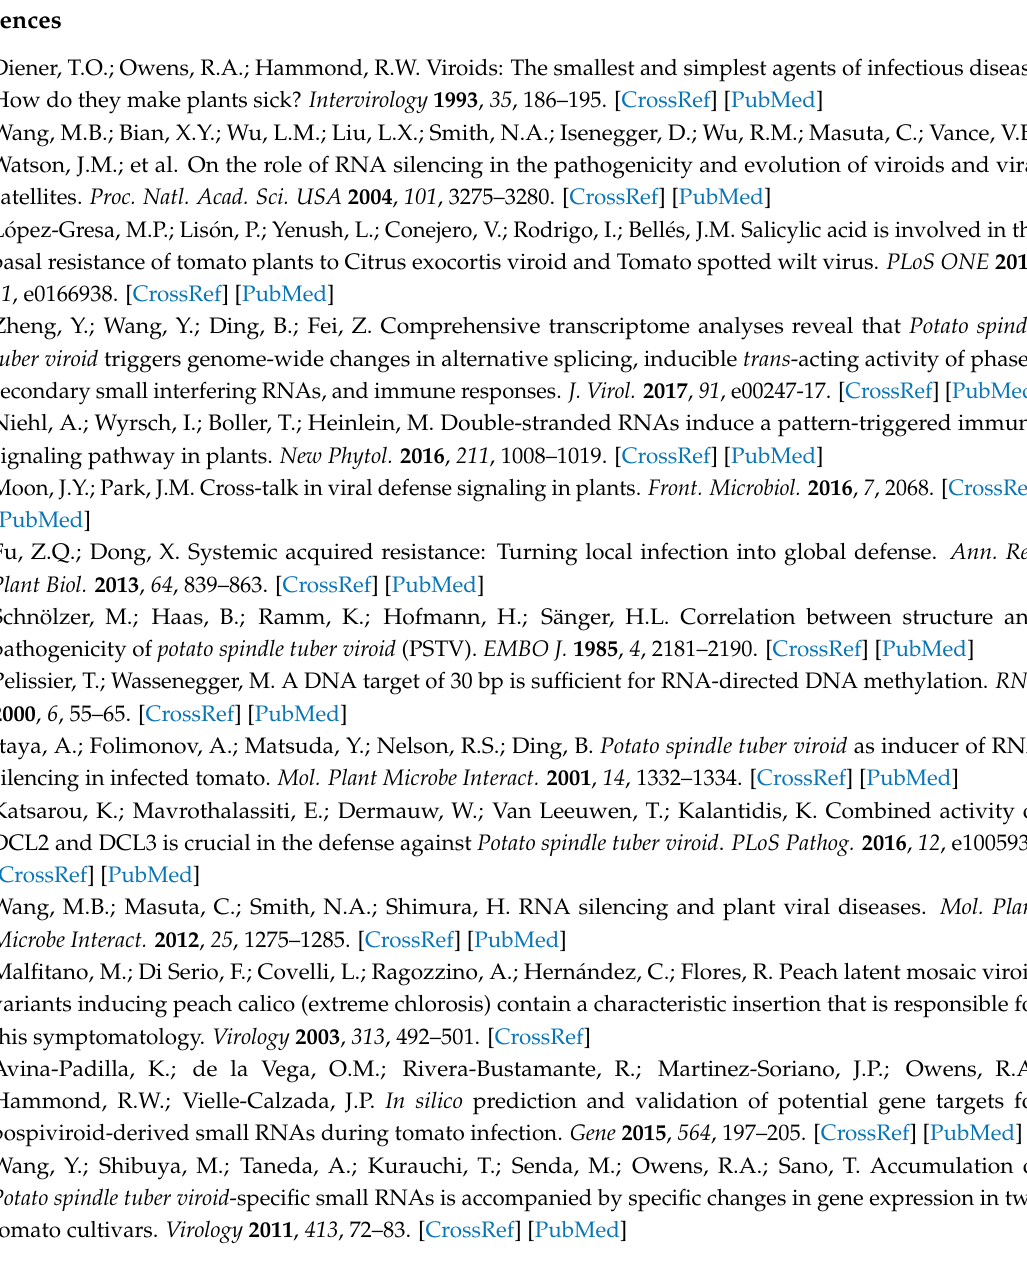
related genes, Table S18: Expression of RNA-dependent RNA polymerase related genes, Table S19: Disease related genes upregulated in infected plants for both PARE and small RNA reads, Table S20: Downregulated genes related to translation, Table S21: Differentially expressed pentatricopeptide genes, Table S22: Downregulated genes related to photosynthesis, Table S23: Differentially expressed genes related to membrane proteins, Table S24: Upregulated excreted protein genes, Table S25: Expression of hormone related genes, Table S26: Expression of hormone related genes statistical